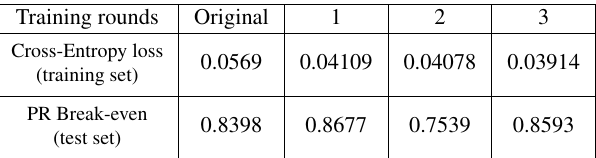
Table 2. Average cross entropy loss of the training samples at each training round of DenseNet. For bootstrap training rounds (denoted as 1,2 and 3), the training loss decreases. However, the precision-recall break-even point of the corresponding test set